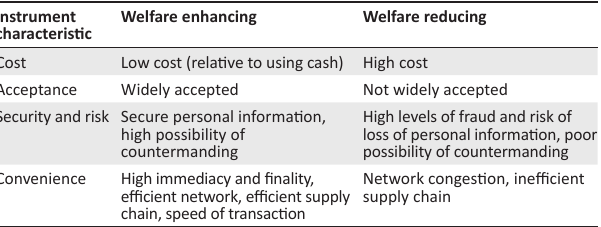
TABLE 1: Welfare effects of payment